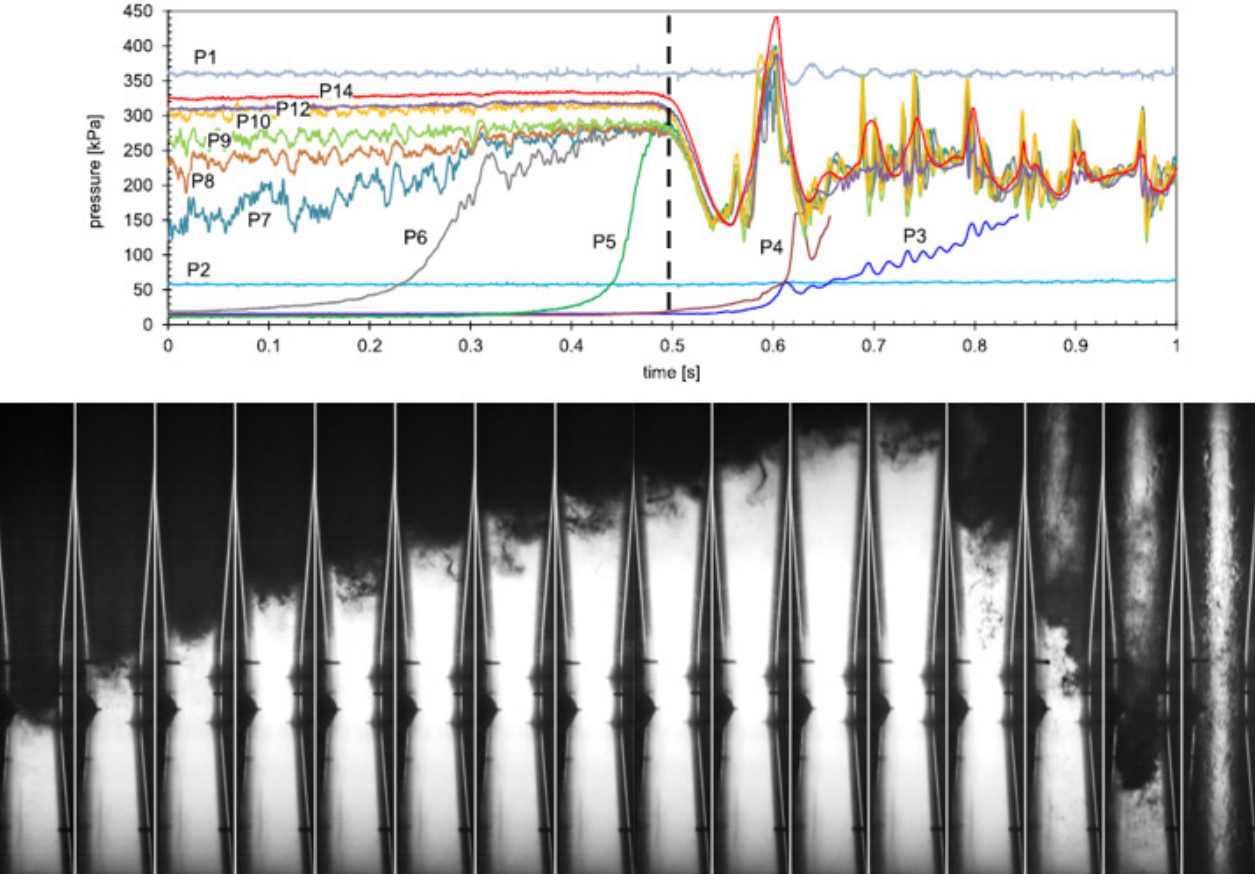
Figure 27. Two phase mixing and condensation phenomena with increasing back pressure [89].